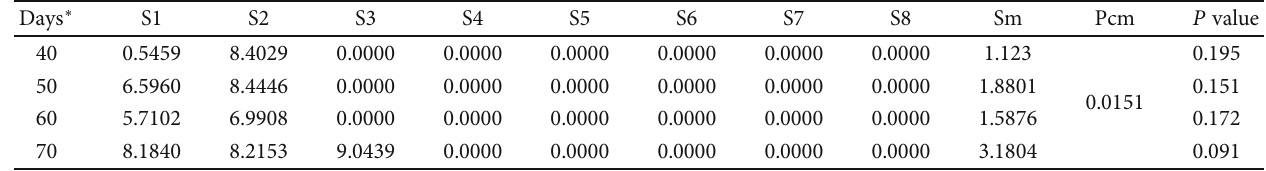
Table 2: Dopamine serum level in mice after parasite